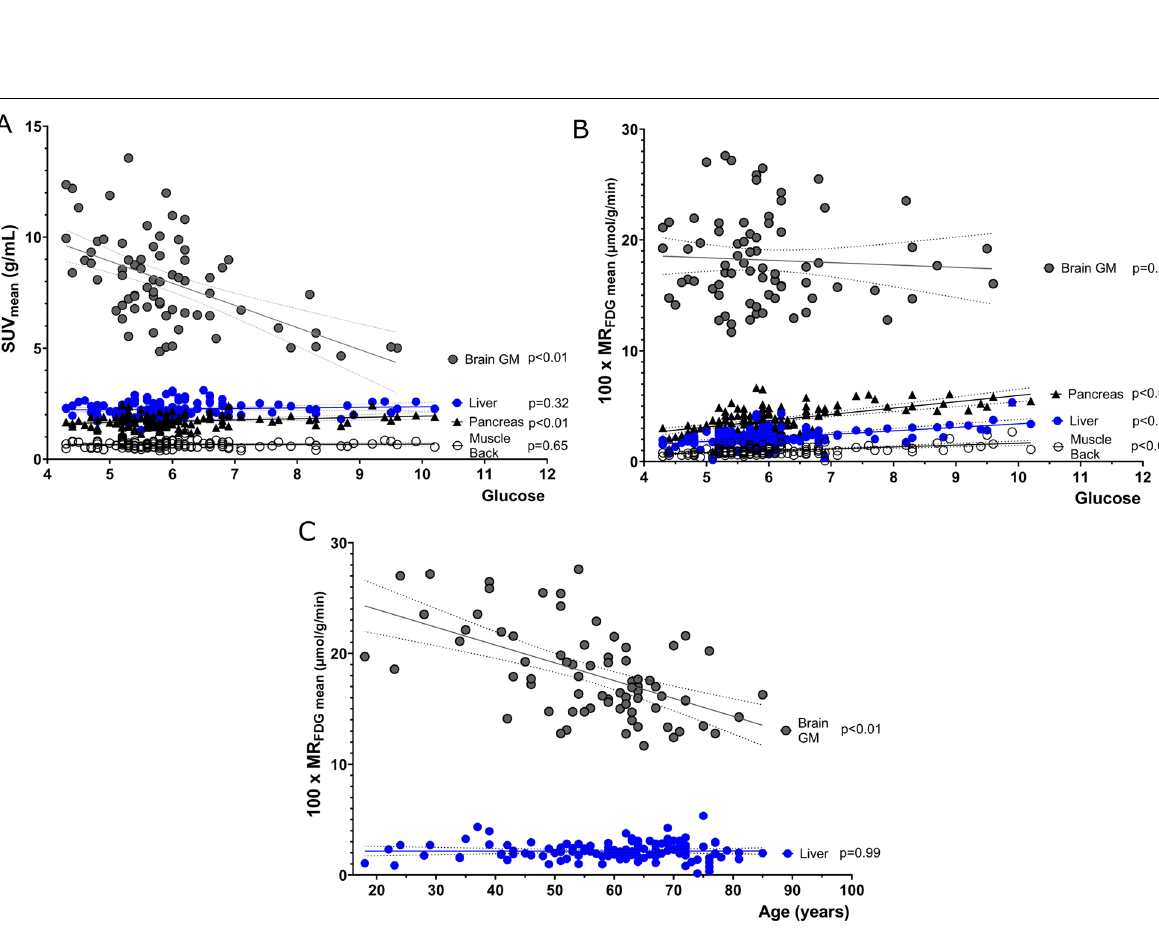
Fig. 6 Correlation of A SUV mean and B MR FDG mean with glucose for brain grey matter, pancreas, liver, and skeletal paravertebral muscle. C Correlation of MR FDG mean and age. Plotted are the VOIs for brain grey matter and liver